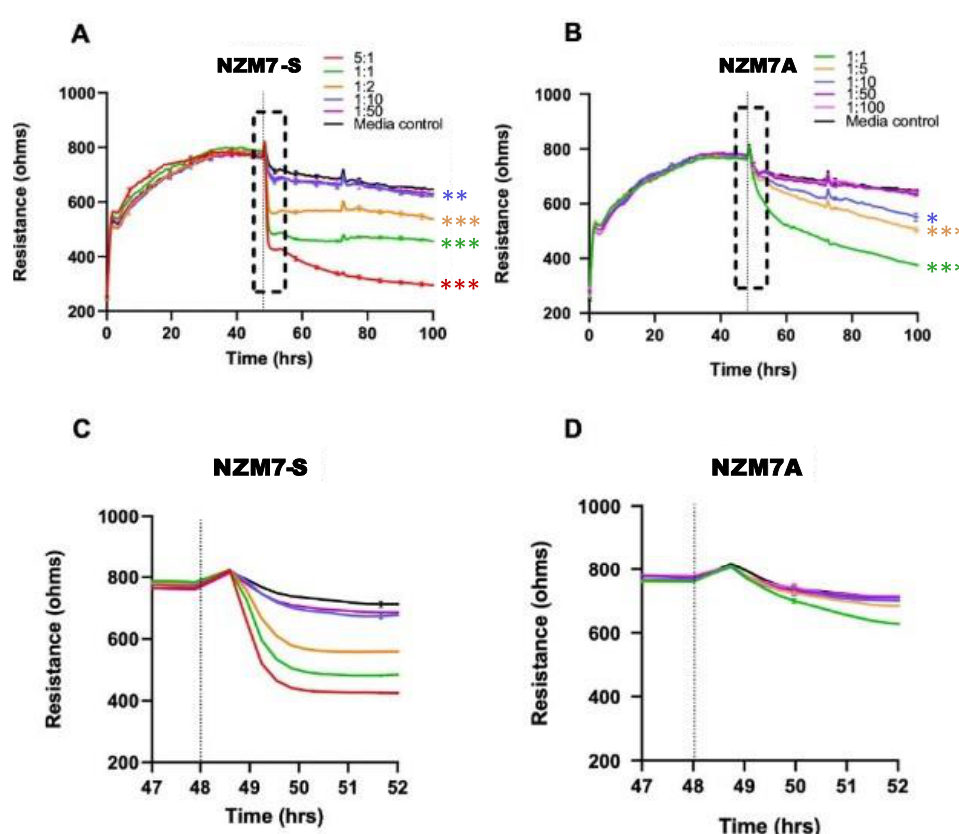
Figure 3. Melanoma-mediated decrease in brain endothelial barrier resistance. Graphs show unmod- elled resistance (at 4000 Hz) of hCMVECs over time after the addition of the NZM7-S and NZM7A cell lines ( A , B , respectively). hCMVECs were seeded at 20,000 cells per well. NZM7 cell lines were added at different Effector:Target (E:T) ratios, where 1:1 shows 1 NZM7 cell added to 1 endothelial cell. Graphs ( C , D ) are representative of the 4 h time period within the box of respective graphs ( A , B ). Data show the mean ± SD ( n = 3 wells) from 1 experiment, which is representative of 3 independent experiments. The 60 h endpoints from independent experiments were compared relative to their media control using two-way ANOVA with Tukey’s range test (* p < 0.05, ** p < 0.01, *** p < 0.001).